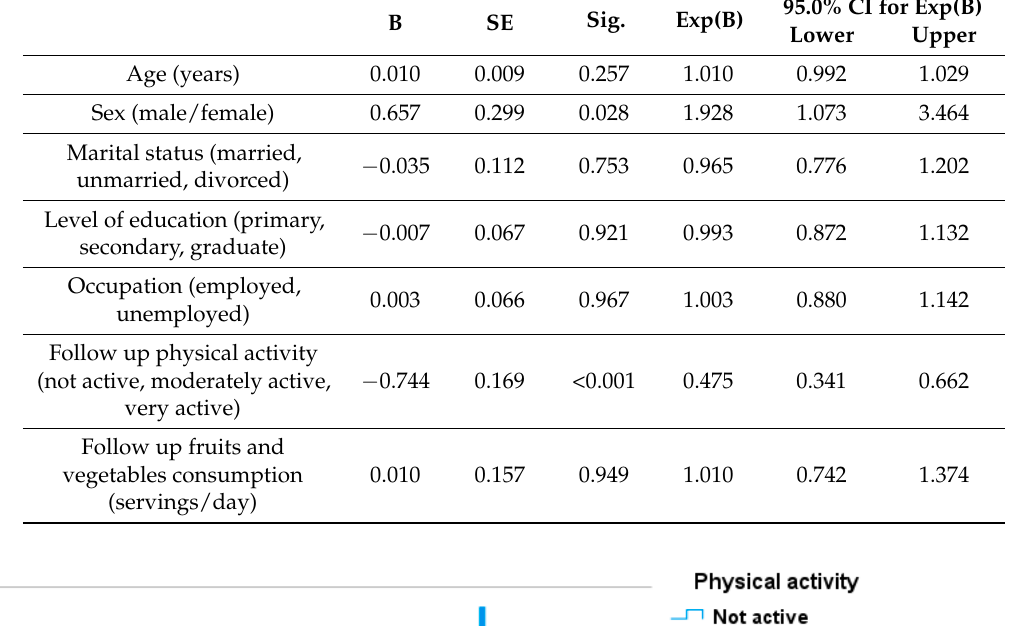
Table 6. The Cox proportional hazard analysis of the relationship between physical activity and other prognostic variables and diagnosis of obesity (BMI => 30) at follow up.